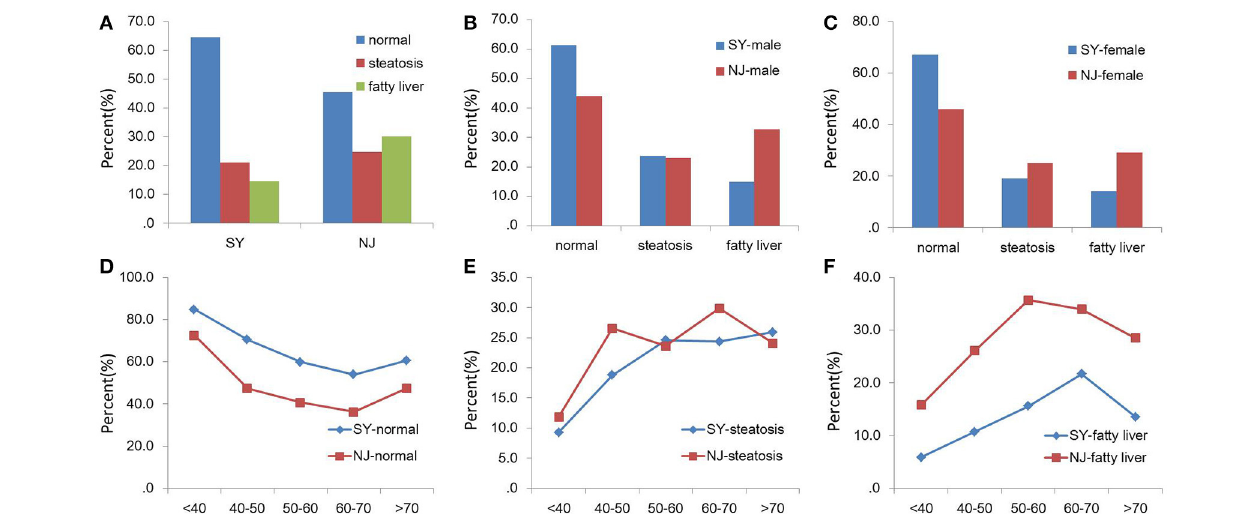
FIGURE 1 | Comparison of NAFLD between SY and NJ. Proportions of normal, steatosis and fatty liver in total (A) , males (B), and females (C) . Proportions of normal (D) , steatosis (E), and fatty liver (F) in different age groups in SY and NJ.